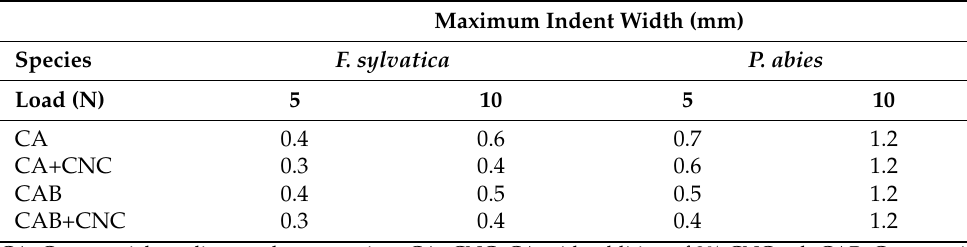
Table 6. Scratch test (EN ISO, 1518-1:2019) results.